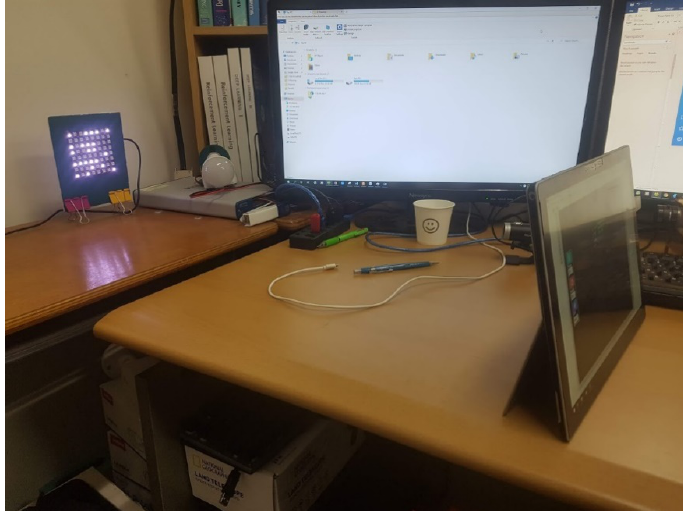
Figure 15. Setup scenario of proposed scheme with LED matrix and tablet.